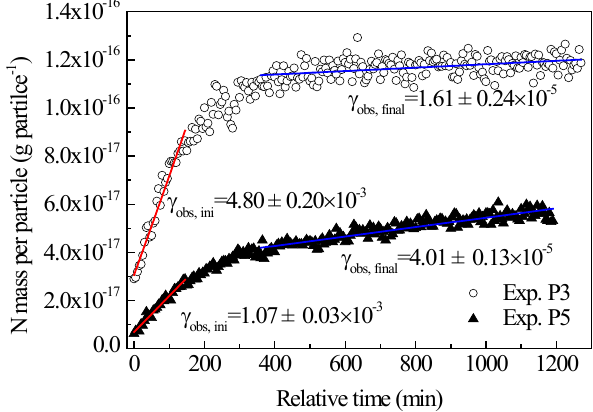
0 Figure 4. Fitting of mass changes (Exp. P3 and P5) to derive uptake coefficients for NH 3 leading to T NOC . The red and blue lines rep- resent the predicted values by the uptake model at the initial (from 0 to 150min) and the final stages of the experiment (from 400 to 1250min),